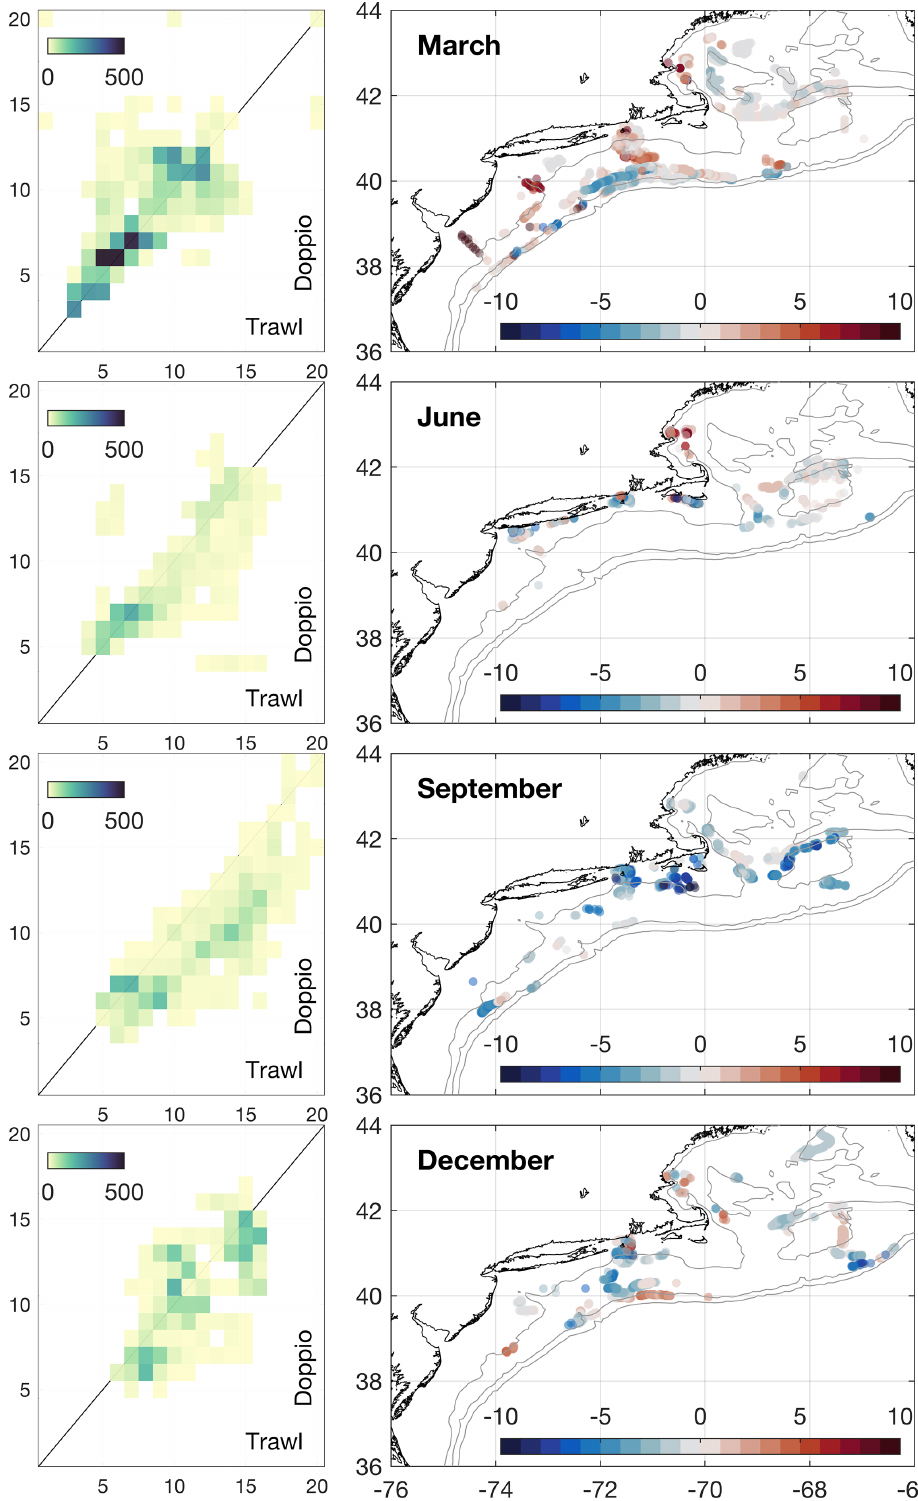
Figure 12. Comparison of bottom temperature observations from fishing trawl data to Doppio for data collected from 2007 to 2017. Left: 2-D histograms ( ◦ C). Right: positions of model-data match-up comparisons, colored by the temperature difference of Doppio minus observed ( ◦ C), where red (blue) means the model is warmer (cooler) than